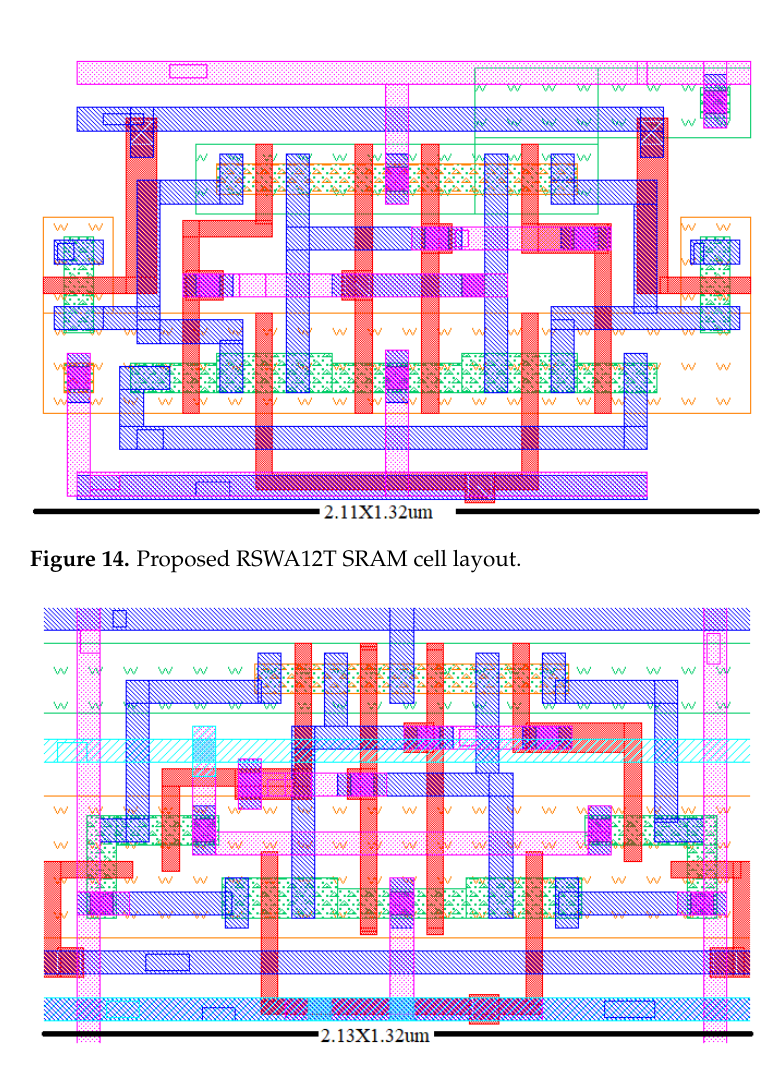
Figure 15. Proposed RSWT12T1 SRAM cell layout.